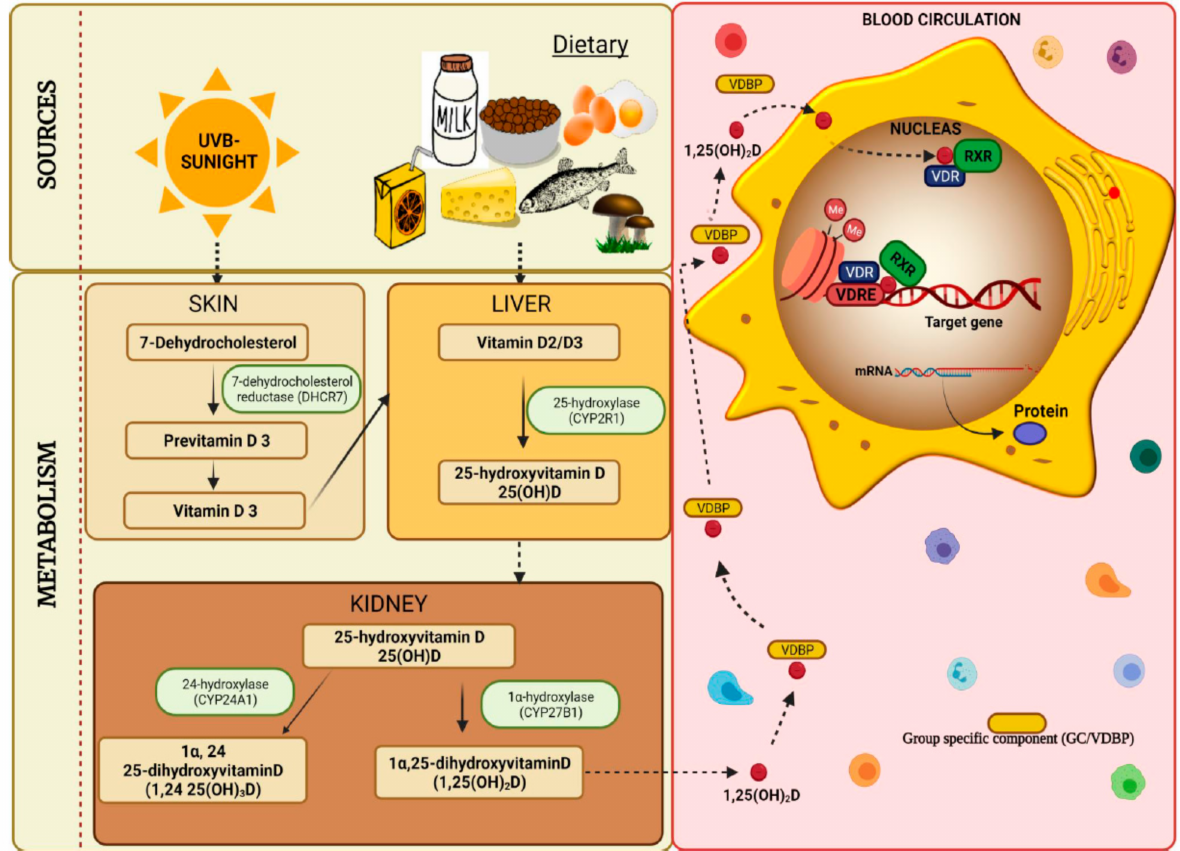
Figure 1. The chosen candidate genes’ involvement in the vitamin D cascade are displayed. Vitamin D is mostly obtained through sunlight or food sources in humans. UVB light from the sun penetrates the skin and converts 7-dehydrocholesterol (7DHC) to pre-vitamin D, which is rapidly transformed to vitamin D. DHCR7/NADSYN1 removes 7DHC from the vitamin D pathway. D is hydroxylated in the liver to 25(OH)D3, primarily by CYP2R1 . Following that, 25(OH)D is delivered to the kidney by vitamin D binding protein (VDBP), which is encoded by GC , where it is converted by CYP27B1 to its active form, 1,25(OH)2D. Finally, CYP24A1 catabolizes both 25(OH)D and 1,25(OH)2D to calcitroic acid, which is physiologically inactive and water soluble. The active form of vitamin D bound to VDBP is delivered in blood to its target cells, where it acts as a ligand for the vitamin D receptor ( VDR ), a nuclear transcription factor that regulates transcription and translation of messenger RNA, leading to the synthesis of vitamin D-dependent